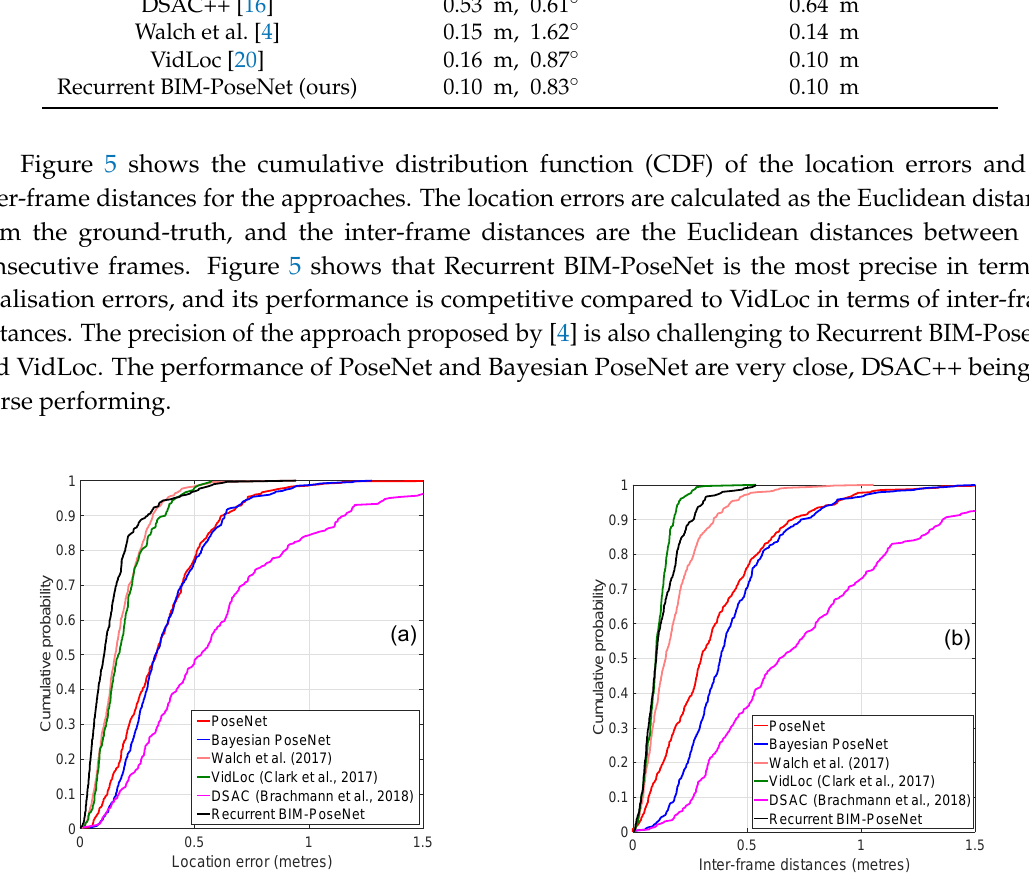
Figure 5. Cumulative distribution function (CDF) plots of the ( a ) errors and ( b ) inter-frame distances of the estimated camera poses for different approaches for Experiment